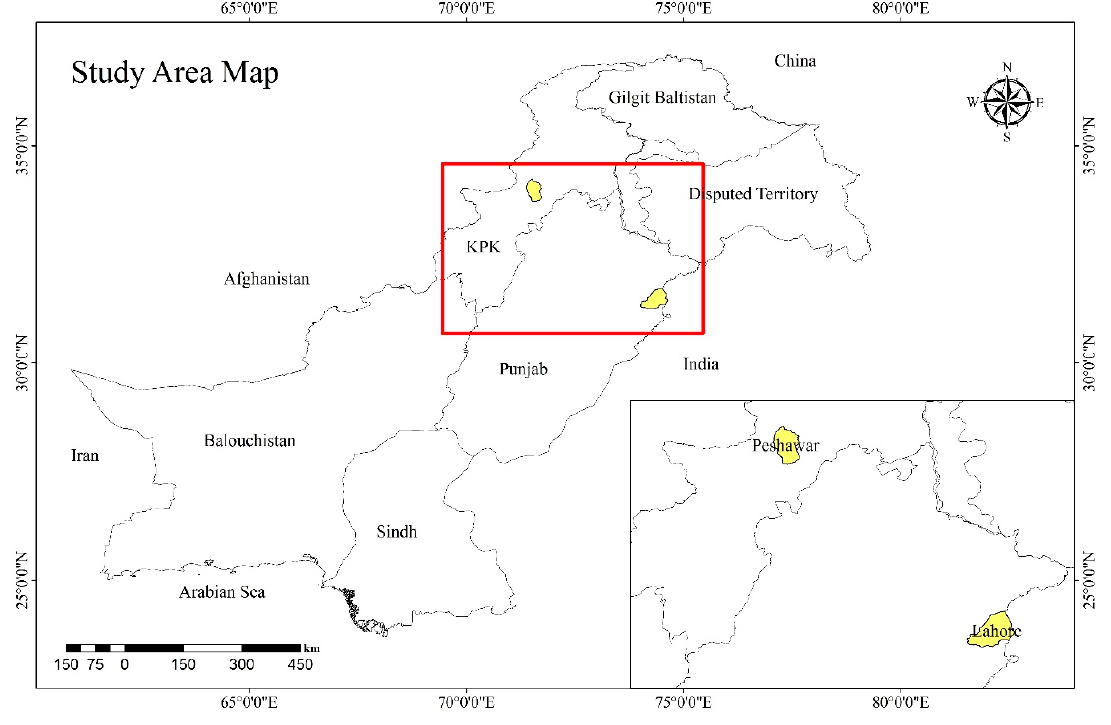
Figure 1. Map of the study area.